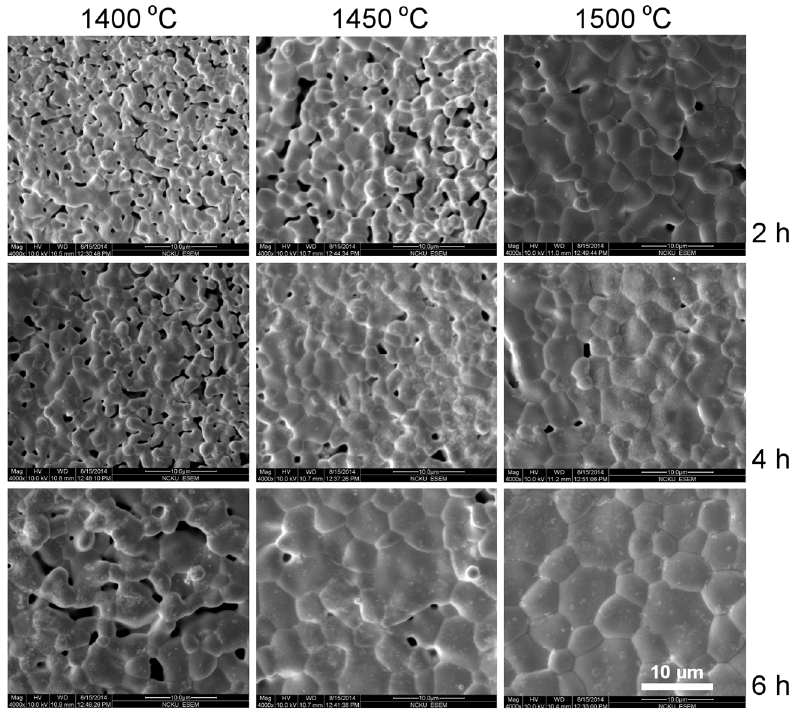
Figure 3. SEM photographs of the YT ceramics sintered at various temperatures and soak